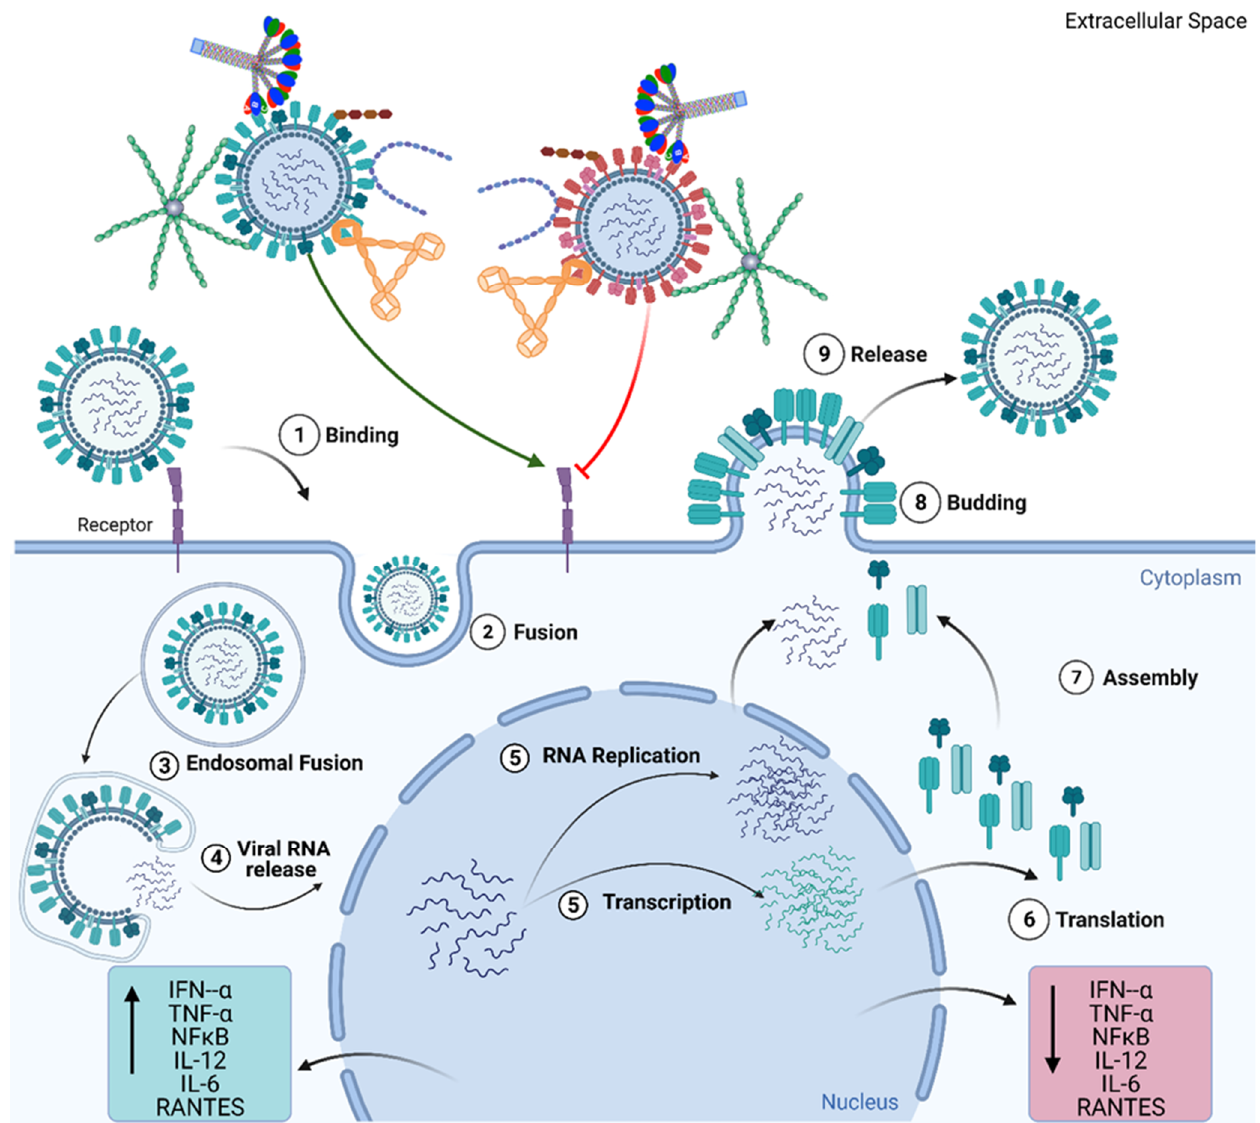
Figure 3. Complement Independent functions of Complement Regulators. Viral infection begins with the attachment of the virus to the epithelial cell surface via cell surface receptors (1) and the internalisation of the virion through endocytosis and fusion (2). Post endocytosis, viral RNA is released into the cytoplasm (3,4), from where it is transported into the nucleus. In the nucleus, the viral RNA undergoes replication and transcription (5). The transcribed mRNA is translated to viral proteins (6). This is followed by the assembly of the virion and subsequent release of the virion from the cell (7,8,9). C1q, C4BP, Properdin, factor H, and VCP have individually been shown to inhibit the entry of viruses, such as the H1N1 subtype of the Influenza A Virus (IAV), (represented by red virion) into the cell and downregulate inflammatory cytokines and chemokines (TNF- α , IL-6, IL-12, NF- κ B, RANTES). However, these complement regulators individually have also been implicated in promoting viral entry, as seen in the case of H3N2 subtype of IAV, and promoting the inflammatory response by upregulating cytokine and chemokines (TNF- α , IL-6, IL-12, NF- κ B, and RANTES). These mechanisms of modulating viral entry in a subtype specific manner, occur in the absence of other complement factors and immune cells, suggesting complement independent viral infection modulating activity for these complement regulatory